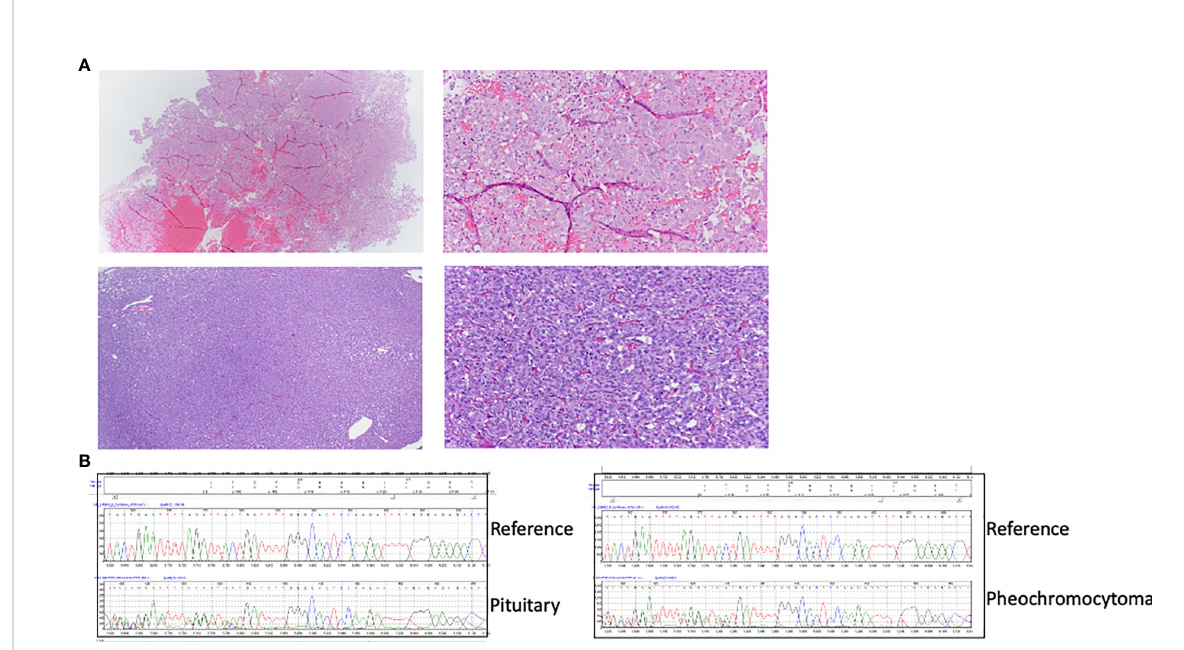
FIGURE 1 (A) HE images of the proband ’ s pituitary adenoma (top) and her sister ’ s pheochromocytoma (bottom). Images on the left were taken at lower (40X) magni fi cation and those on the right at higher (100X) magni fi cation. (B) CHEK2 sequence traces from DNA obtained from the proband ’ s pituitary adenoma (top) and the sister ’ s pheochromocytoma(bottom), obtained from formalin- fi xed paraf fi n embedded (FFPE) tissue, showing the presence of a frameshift variant (c.1000delC) and consistent with retention of both alleles or the presence of nontumoral admixed cells in the DNA. Reference wild-type sequence is shown for comparison.